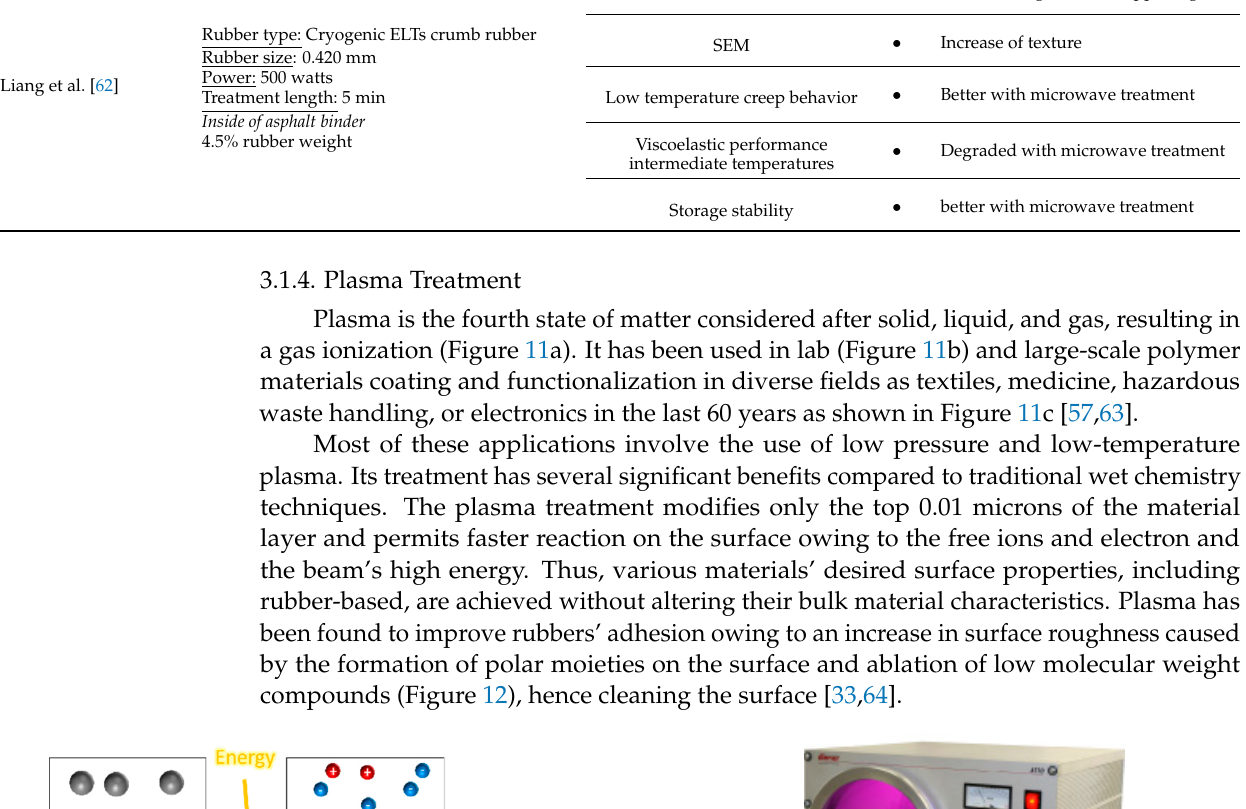
Figure 12. Simplified scheme of plasma effect on rubber surface. In a research by Ortiz ‐ Magan et al. [65], both nitrogen N 2 and oxygen O 2 plasma treat ‐ ment were used to improve rubber adhesion to another polymer (polyurethane), gener ‐ ally used for playgrounds or in the shoes industry together with the crumb rubber. The reaction was conducted for 1–15 min using a 50 W power reactor. In general, zinc and oil on rubber, due to the vulcanization, create an anti ‐ adherent layer on the surface, decreas ‐ ing the interaction between the rubber and the studied adhesive. In this specific study, the more noticeable effect was the grafting of oxygen and enhancing rubber’s surface texture owing to O 2 plasma [65]. The wettability was considerably improved owing to removing